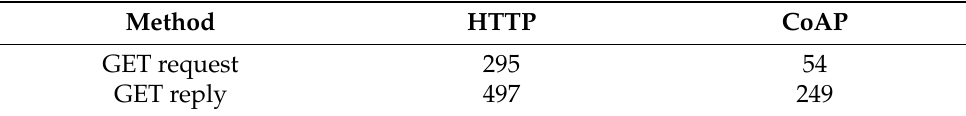
Table 4. Number of exchanged bytes per a single detected object.